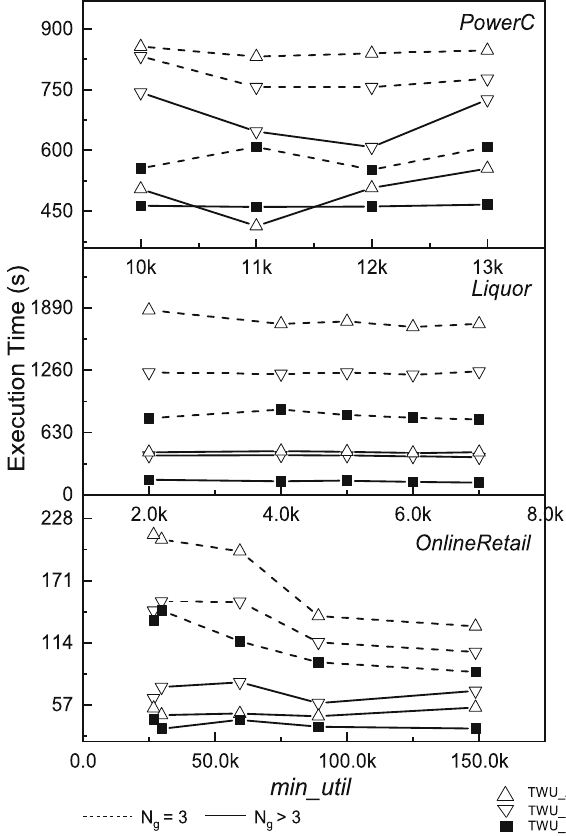
Figure 4: Comparison of TWU - grouping